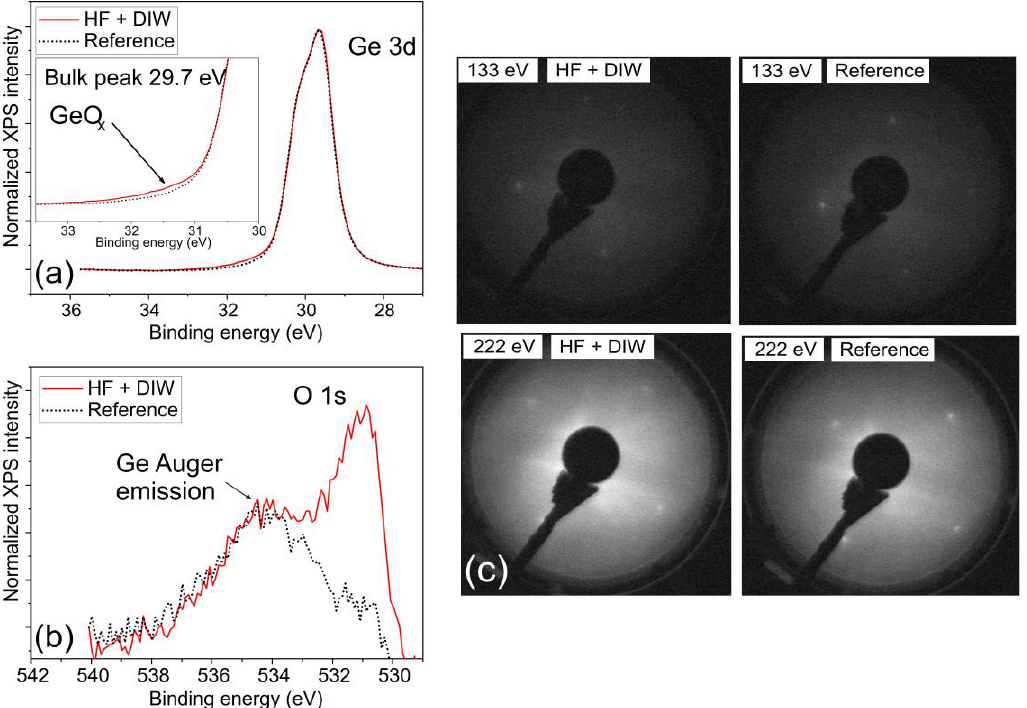
Figure 2. ( a ) Ge 3d and ( b ) O 1s XPS spectra for HF + DIW-cleaned samples. HCl-cleaned sample is shown as a reference. ( c ) LEED patterns for same samples.